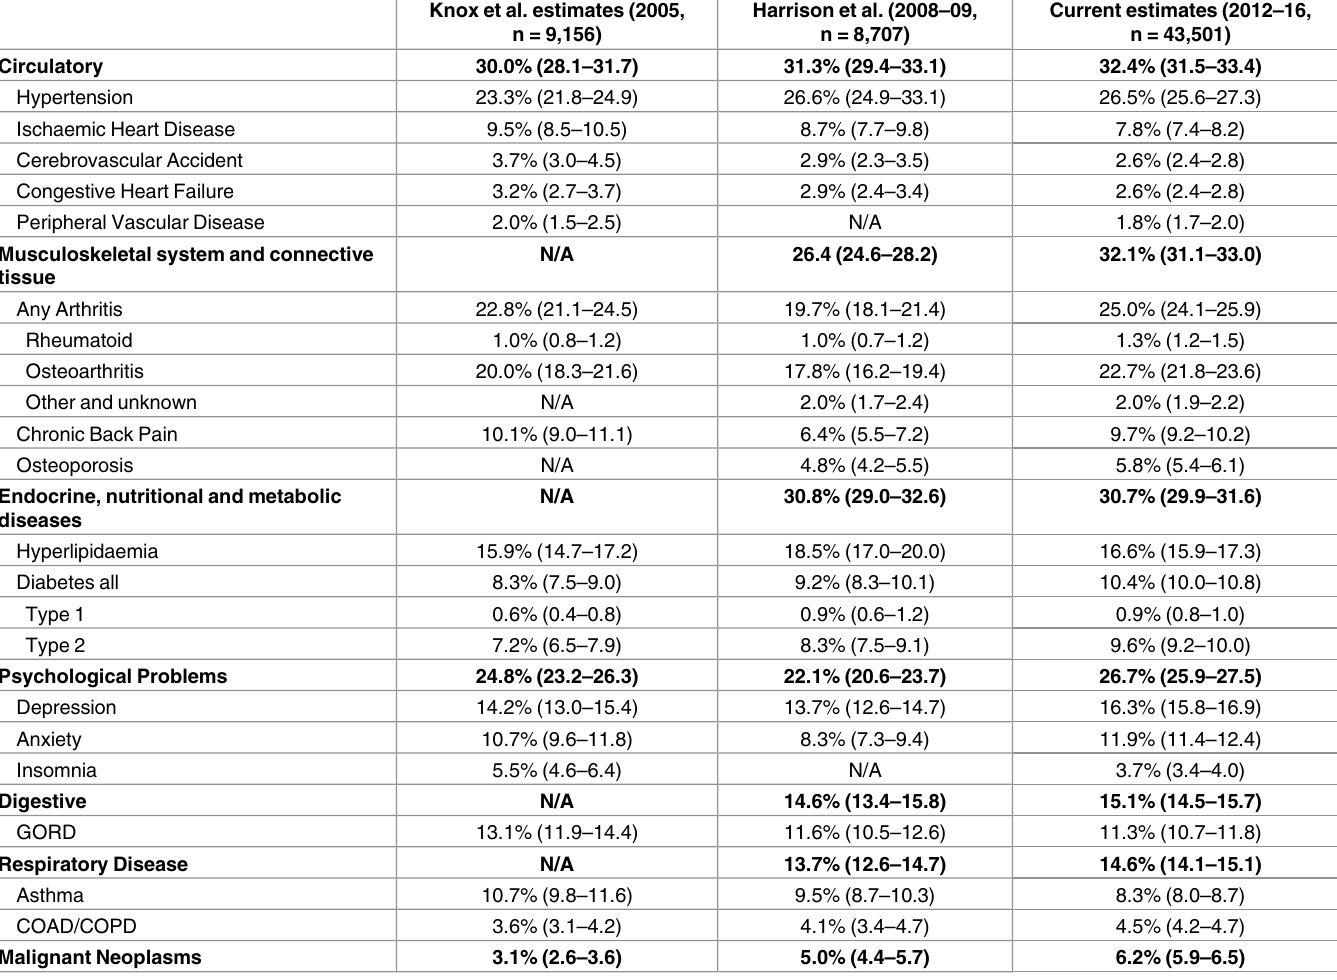
Table 3. Prevalence of common diagnosed chronic conditions among patients at GP encounters across three